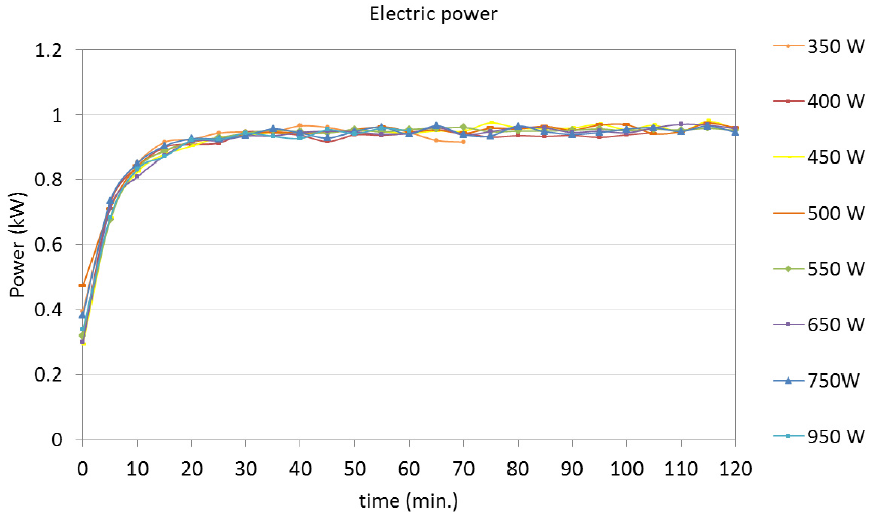
Figure 3. Power generated as a function of time for the different tests in